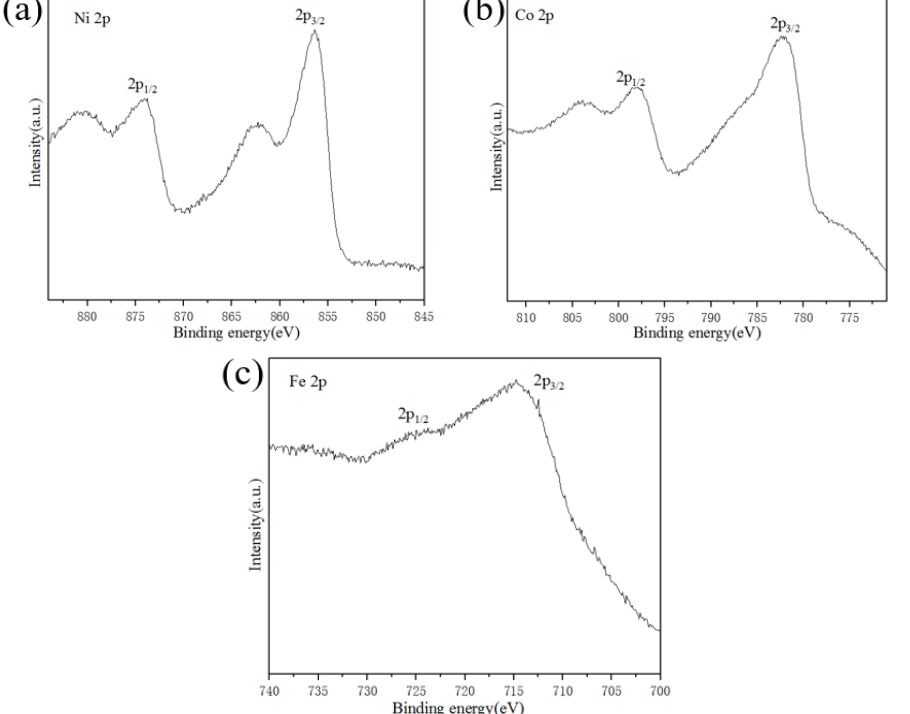
Figure 6. XPS spectra of Ni 4 Co 4 Fe 2 -LDH/NF: ( a ) Ni 2p, ( b ) Co 2p, ( c ) Fe 2p.